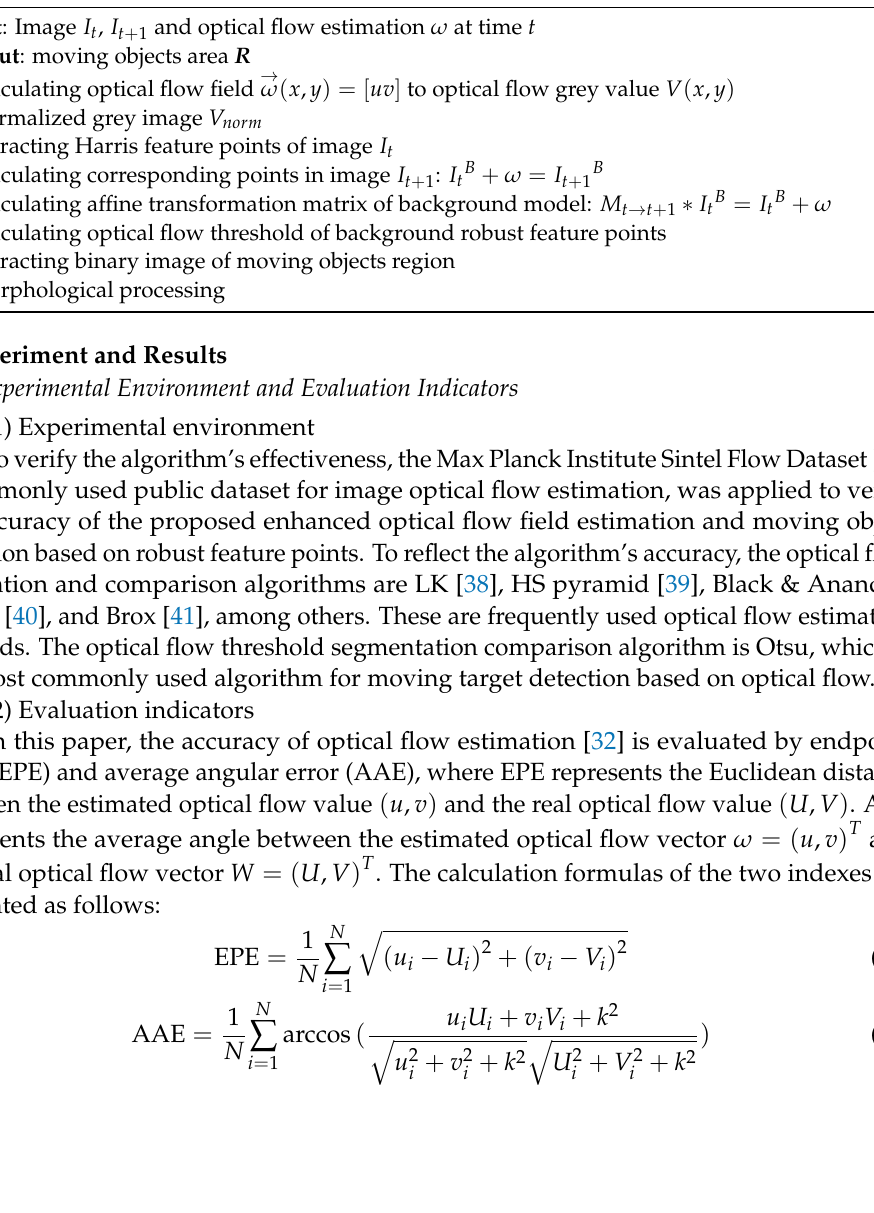
Figure 5. The normalization of the image optical flow field and extraction of moving object fore- ground region. ( a ) Grey image of the optical flow, ( b ) binary image of robust Harris feature points thresholding, ( c ) binary image after morphological processing, and ( d ) mask of the target area. The pseudo-code of moving object detection is as Algorithm 2: Algorithm 2 Moving object detection